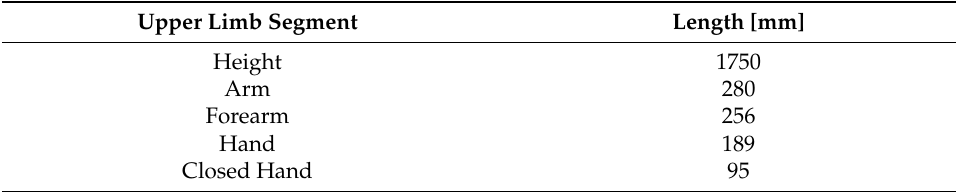
Table 2. Lengths of the upper limb segments (50th percentile Italian male).